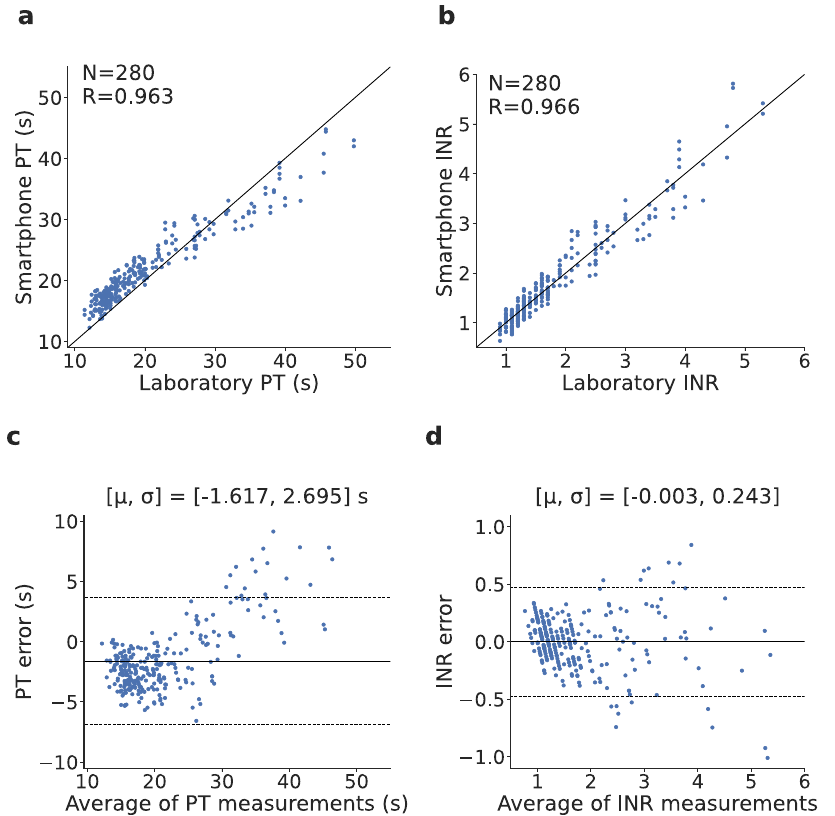
Fig. 3 Plasma clinical testing results. a – d Correlation and Bland-Altman plots comparing plasma PT/INR values from the smartphone system and the clinical-grade coagulation analyzer. In the Bland-Altman plot, μ is the mean error and σ is the standard deviation (SD) of the errors, the solid line represents the mean error and the dotted lines represent the 95% limits of agreement. Source data are provided as a Source Data fi le.